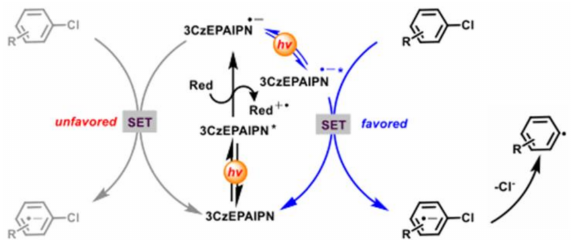
Figure 18. Proposed mechanism of reduction of aryl radicals by consecutive visible light-induced electron transfer processes with 3CzEPAIPN. Reprinted with permission from Ref. [66]. Copyright 2021, American Chemical